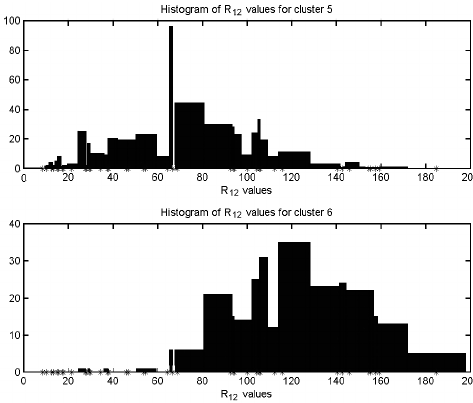
Fig. 18.22. Histogram of R 12 values (from 8.6 to 184.8), for Cluster 5 and Cluster 6.